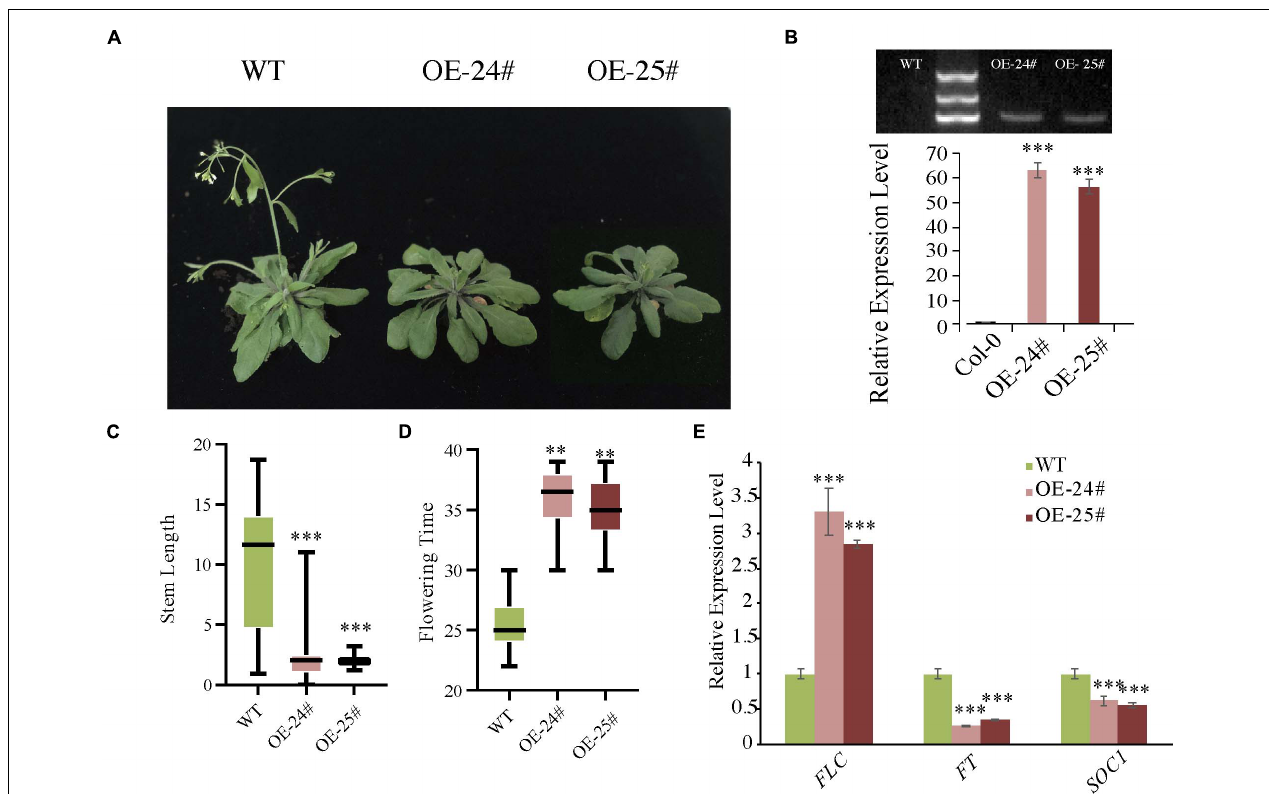
FIGURE 8 | Overexpression of AcoSBT1.12 in Arabidopsis delayed floral transition with the expression level of FLC increased while FT and SOC1 decreased. (A) Characterization of the flowering phenotype of AcoSBT1.12 OE lines. (B) The gel electrophoresis results and qPT-PCR results confirmed the reliability of OE lines. (C) Stem length on the 40th day, the error bars indicate + SD. (D) Flowering time of WT and OE lines, the error bars indicate ± SD. (E) Relative expression level of flowering regulator genes. Asterisks indicate significant differences for the indicated comparisons based on Student’s t -test ( ∗∗∗ p < 0.001; ∗∗ p <